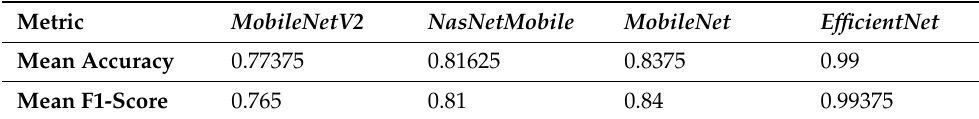
Table 5. Mean Accuracy and F1-scores of best performing models of each network.